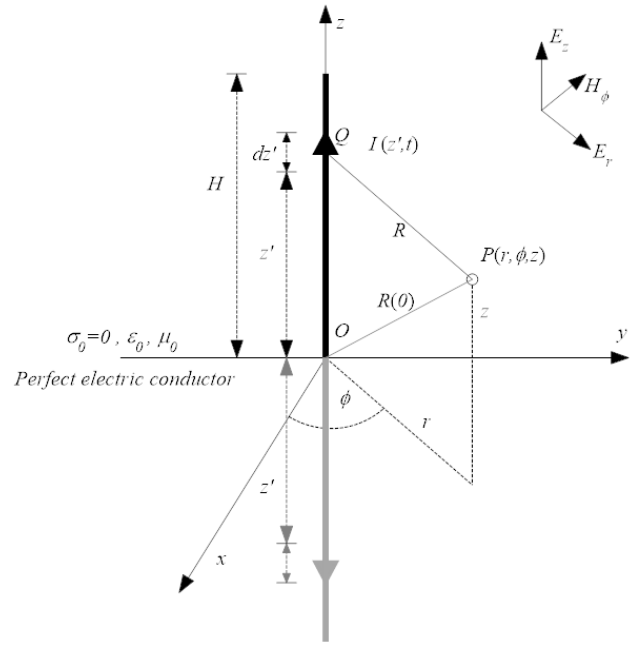
Figure 1. Geometry of the considered system.